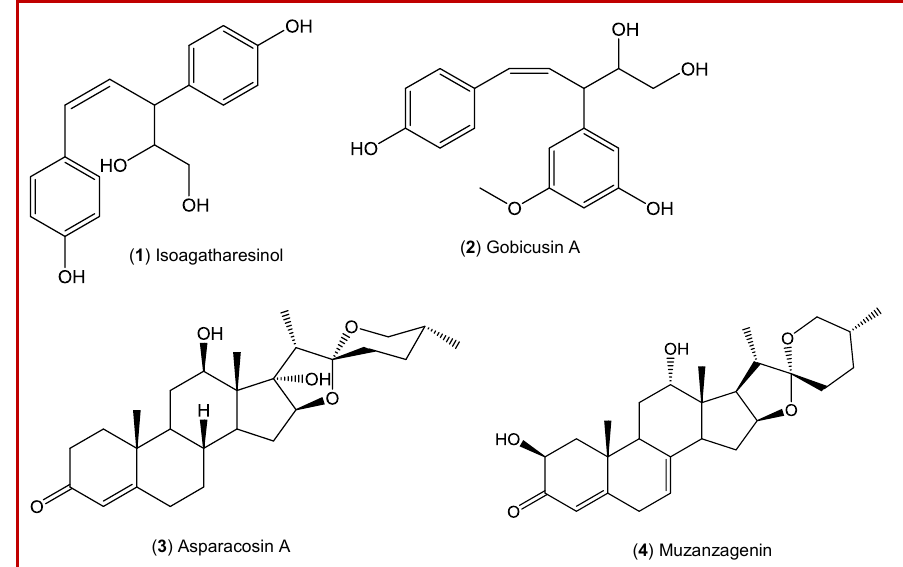
Figure 1: Chemical structures of the isolated